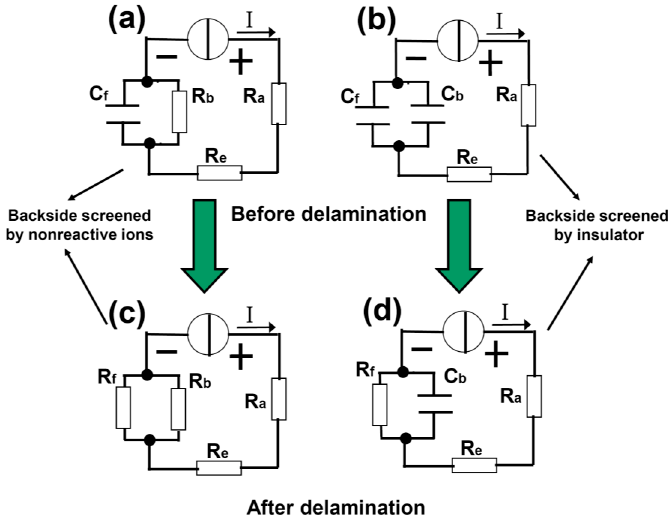
Figure 2. Capacitor model of the electrochemical delamination of 2D materials. ( a , b ) are before while ( c , d ) are after the delamination. The delamination is modeled by the C f (formed between the solution and substrate) breakdown into R f , which is boosted by two types of screening effects from nonreactive ions and stable insulator at the backside of substrate.